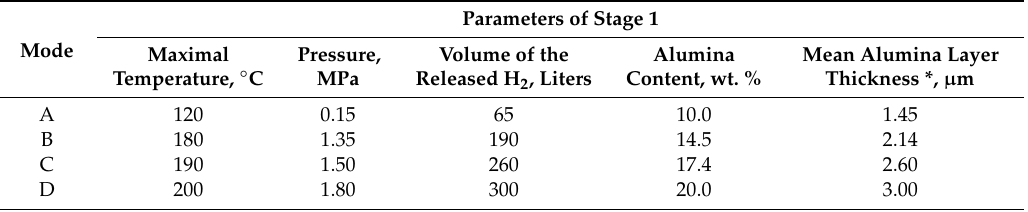
Table 1. Parameters of obtaining aluminum-alumina powdery